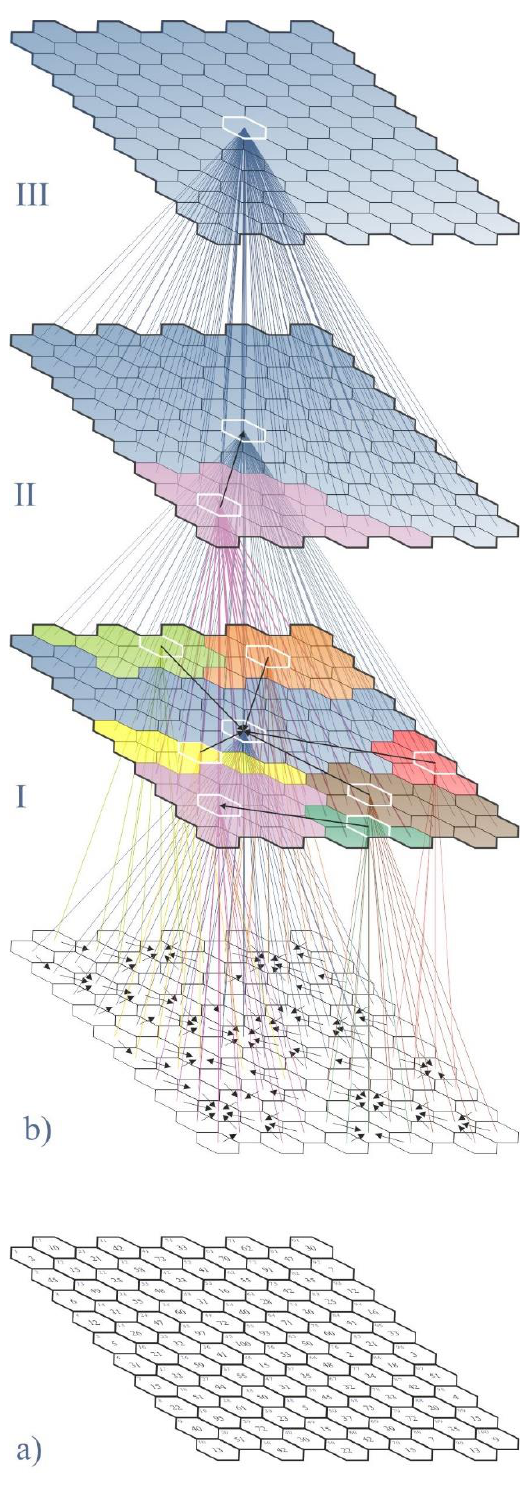
Figure 7. The levels of network emergence according to the path of maximum increase in the spatial interaction indicator (aggregation levels): ( a ) basic fields with the assigned values that reflect a studied phenomenon; ( b ) the stage of revealing relationships; in this case, the maximum value increase; ( I ) the first stage of value aggregation according to the maximum value increase path; ( II ) the second stage of value aggregation according to the maximum value increase path; ( III ) the third stage of value aggregation according to the maximum value increase path. Source: Own analysis.